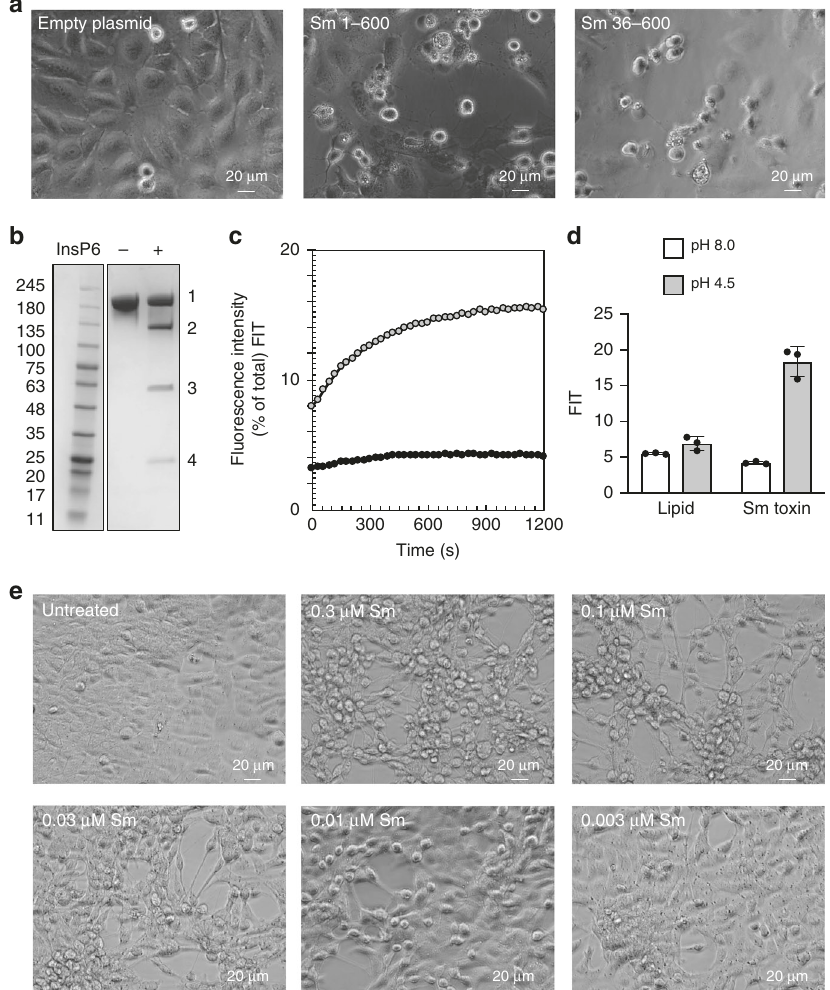
Fig. 3 Characterization of S. marcescens (Sm) toxin. a Light microscopy images of HeLa cells transfected with PiggyBac Dual Promoter PB5131B-1 vector, expressing empty plasmid or Sm toxin effector (1 – 600 or 36 – 600) after 24 h. b Addition of Insp6 ( + ) to Sm toxin results in cleavage of the effector (band 3) and the CPD (band 4) from the full-length toxin (band 1). Band 2 represents full-length Sm toxin without the effector and CPD. c Dye release from HPTS/DPX loaded liposomes at pH 4.5 and pH 8.0. d Quanti fi cation of dye release from HPTS/DPX loaded liposomes after 20 minutes. N = 3 for all experiments. Source data are provided as a Source Data File for Fig. 3e. e Light microscopy images of HCT-116 cells with no toxin (untreated) or with varying concentrations of Sm toxin after 24